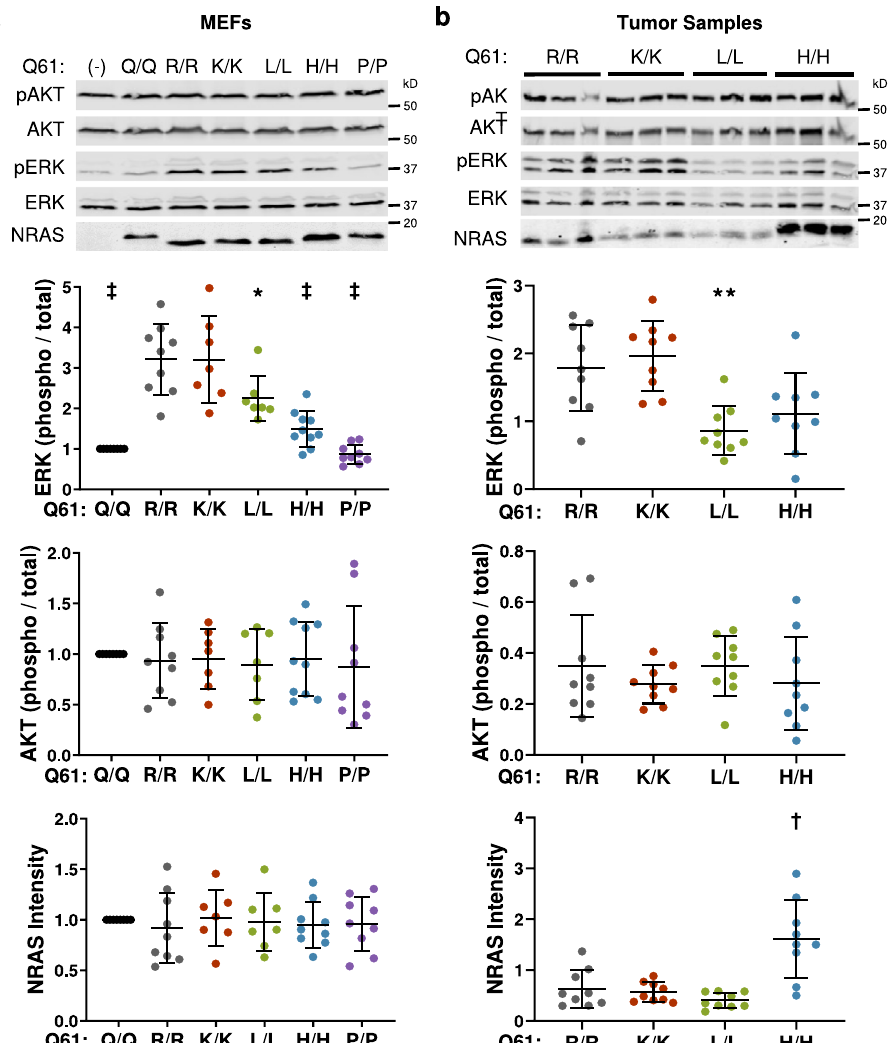
Fig. 4 MAPK pathway activation parallels the tumorigenic potential of oncogenic NRAS mutant. Immunoblot of protein lysates isolated from MEFs ( a ) or murine melanomas ( b ) expressing the indicated NRAS mutants. Dot plots showing the quanti fi cation of ERK activation, AKT activation, or NRAS expression. Dot plot data are presented as mean values + / − SD where each dot represents one biological replicate. For a following number biologically independent replicates per genotype were examined over nine independent experiments (Q/Q = 9, R/R = 9, K/K = 7, L/L = 7, H/H = 9, P/P = 9). For b nine biologically independent replicates were assessed per genotype. One-way ANOVA with a Tukey ’ s post-test was used to compare data between each genotype. NRAS mutant samples statistically different from NRAS 61R/R samples are indicated in the fi gure. Adjusted p -values for all comparisons can be found in Supplementary Table 3a. * p < 0.05, ** p < 0.01, † p < 0.001. Source data are provided as a Source Data fi